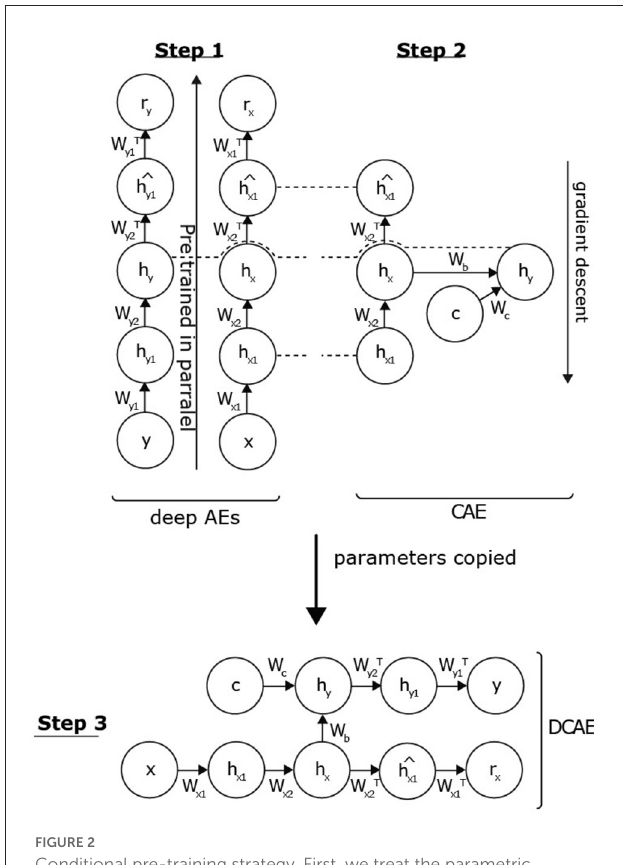
FIGURE2 Conditional pre-training strategy. First, we treat the parametric functions associated with the extraction of features of the data distributions p ( x ) and p ( y ), considering them as two deep AEs. As previously pointed out, it is possible to initialize these networks by learning by applying the unsupervised pre-training algorithm. Being independent, these two models can be processed in parallel (step 1: parallel pre-training). After this first step, we are able to extract the probabilities of the hidden layers h y and h x 1 by inference. The initialization of the parameters associated with the supervised conditional link is then performed through an CAE trained to answer the problem p ( h y | h x 1 , c ) (step 2: supervised conditional link). These two successive steps initialize all the hidden layers of the DCAE. It is then necessary to then export the various weight matrices within the deep architecture in order to jointly adjust all the parameters of